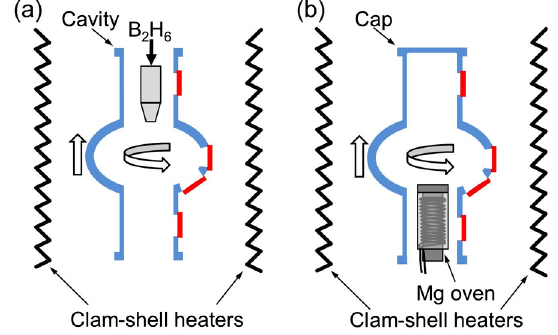
FIG. 10 (color online). Schematic views of the two-step process: (a) boron film deposition and (b) annealing of the boron films in Mg vapor.